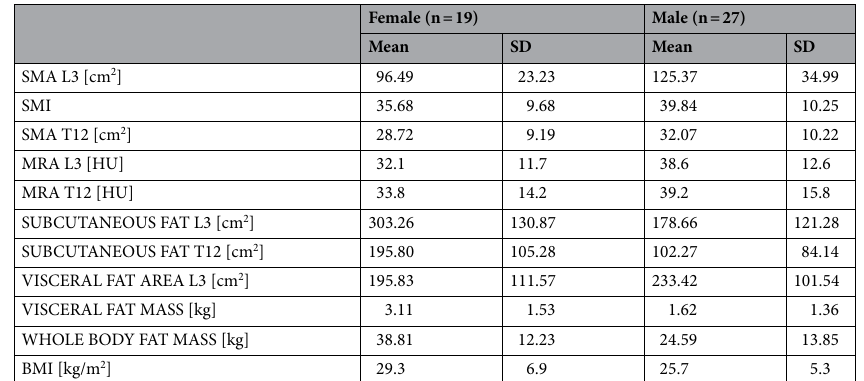
Table 1. Sex-specific muscle and fat parameters. Sex-specific mean and standard deviation (SD) of the skeletal muscle area (SMA), muscle radiodensity attenuation (MRA), and subcutaneous fat area are provided at the level of the third lumbar vertebra (L3) and twelfth thoracic vertebra (T12) on axial contrast-enhanced computed tomography slices. Additionally, mean and SD of the visceral fat area at L3, visceral and whole-body fat mass, the skeletal muscle index (SMI), and the body mass index (BMI) are